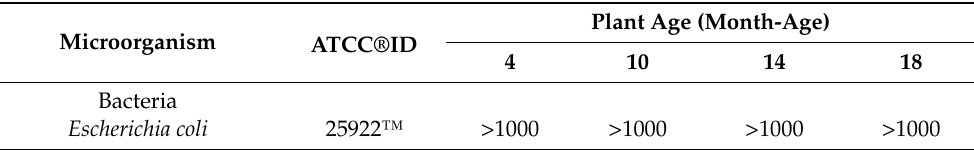
Table 3. Minimum inhibitory concentration (MIC, µ g/mL) values of essential oil samples produced from V. curassavica at different ages against bacteria and